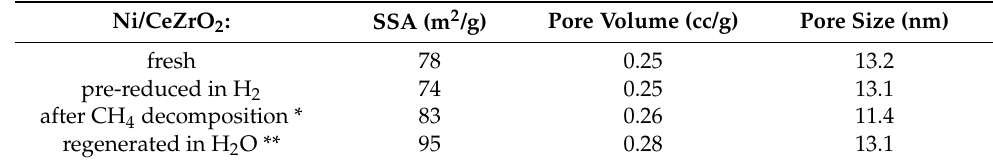
Table 2. Textural properties of fresh, spent, and regenerated Ni/CeZrO 2